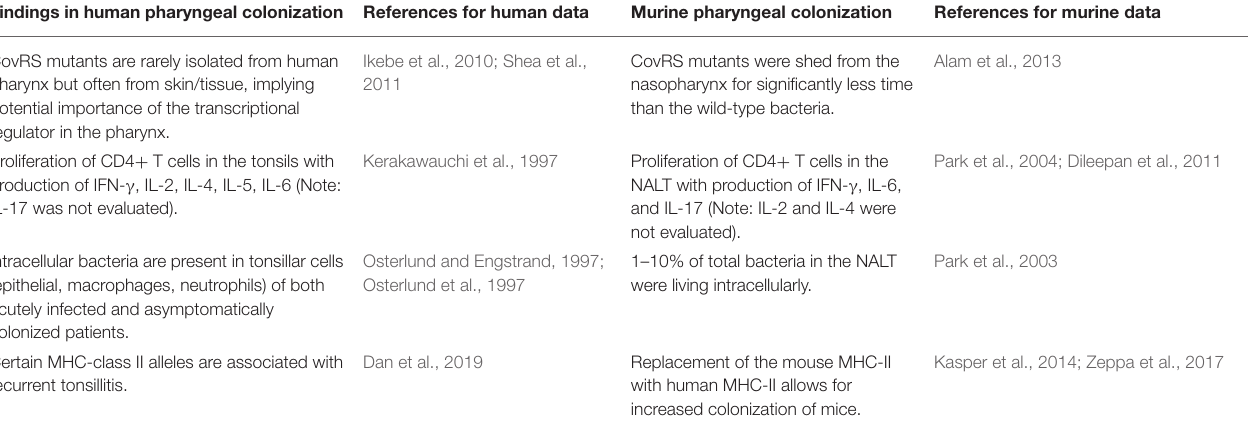
TABLE 2 | Comparison of coupled findings in human and murine pharyngeal colonization studies, with supporting references. Findings in human pharyngeal colonization References for human